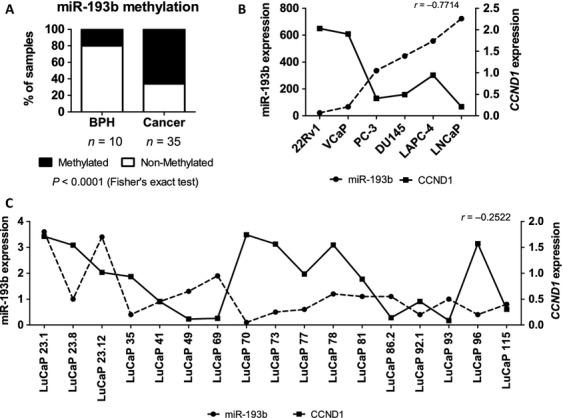
miR-193b is methylated in cancer samples and has inverse expression pattern compared to CCND1. (A) miR-193b methylation in clinical samples (BPH, PC, and CRPC) was assessed by MethylMiner-qPCR. miR-193b and CCND1 expressions were studied by miRNA and mRNA microarray (B) in prostate cancer cell lines and (C) xenograft samples. Spearman correlation coefficiencies are given. BPH, benign prostate hyperplasias; CRPC, castration-resistant tumors; PC, prostate cancer.